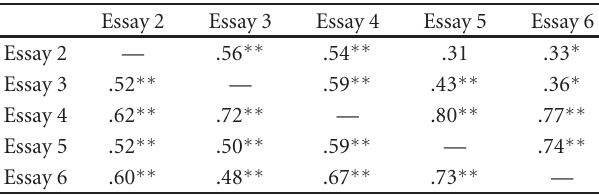
Table 1: Intrameasure correlations for performance predictions (upper triangle) and confidence in performance predictions (lower triangle) from essays 2 through 6, n = 38.